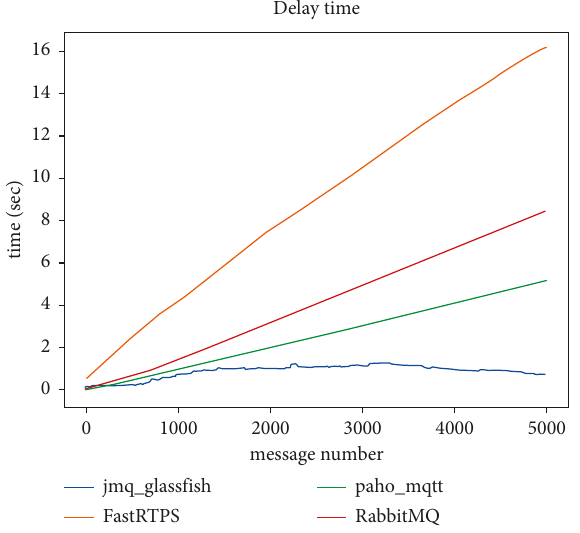
Figure 4: Delay of messages with the size of 60